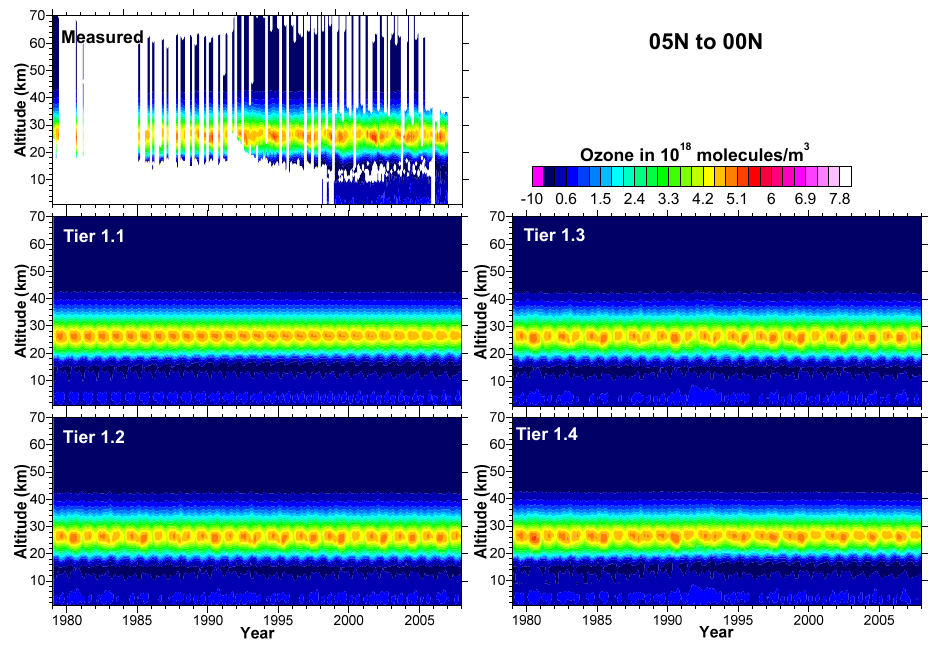
Fig. 7. As for Figure 6 but for 0 ◦ N to 5 ◦